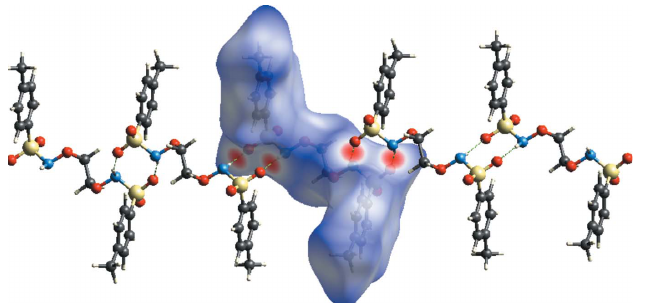
Figure 5 Hirshfeld surface mapped over d norm to visualize the intermolecular interactions in the title compound.